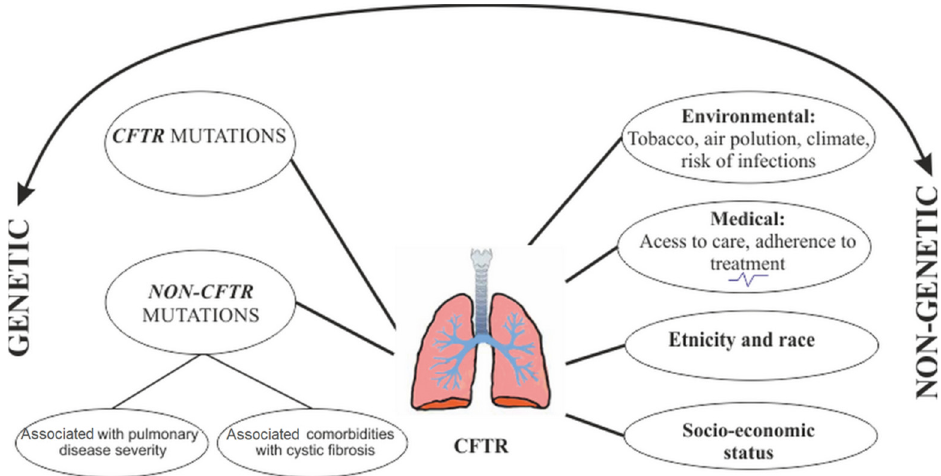
Figure 1. Genetic and non-genetic modifiers of phenotype in cystic fibrosis: the interaction between the CFTR genotype with modifier genes and environmental factors.